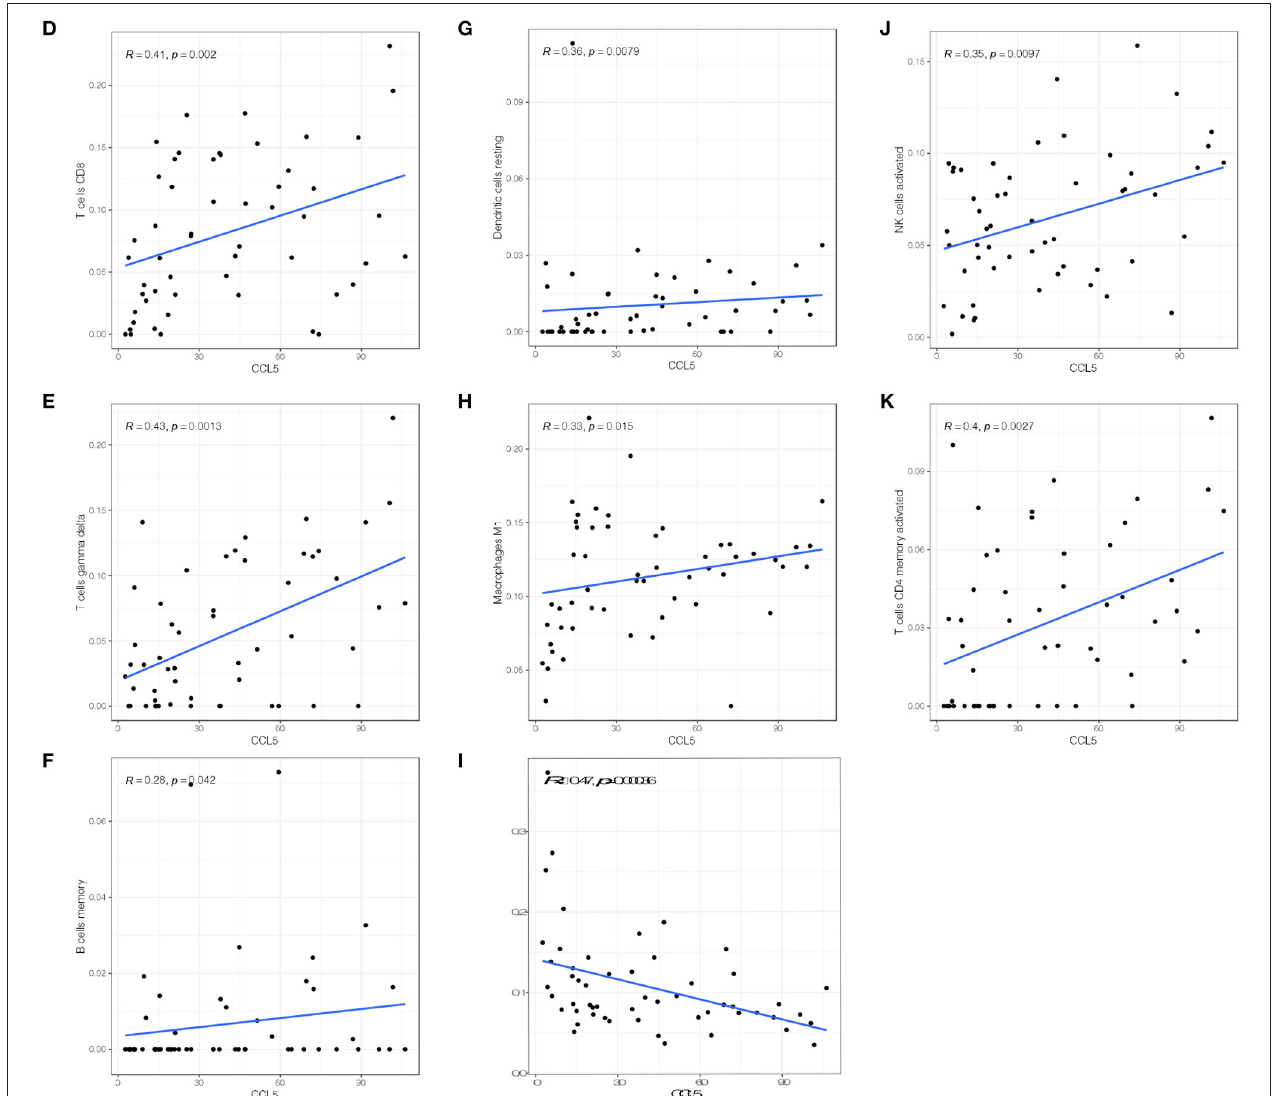
FIGURE 6 | (A) Bar plot shows the proportion of 21 types of TICs in SCLC tumor samples. (B) The heatmap shows the correlation between 21 TICs and the value in each small box and represents the P -value of the correlation between the two cells. The shadows in each tiny color box represent the corresponding correlation values between the two cells, and significance was assessed using Pearson’s coefficient. (C) The violin plot shows the proportional differentiation of 21 immune cells relative to the median level of CCL5 expression in SCLC tumor samples with low or high CCL5 expression. (D–K) Scatter plot showing that the proportion of 8 TICs was correlated with CCL5 expression ( P < 0.05). The blue line in the figure indicates the fitted line of the linear model, indicating the proportion of immune cells and CCL5 expression. Pearson’s coefficient was used for the correlation